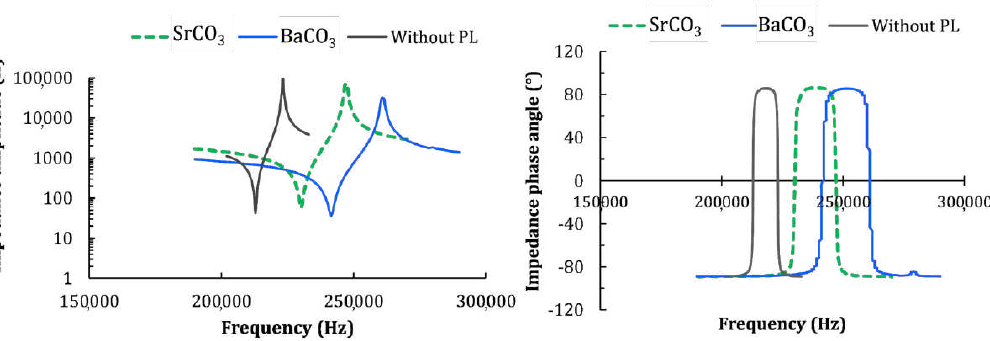
Figure 9. Comparison of impedance amplitude and impedance phase angle as a function of frequency for ceramics sintered by SPS with and without carbonates protective layers. Without PL refers to ceramics fabricated by SPS without a protective layer and post-annealed at 800 ◦ C for 6 h. These values are approaching those of a commercial PZ26 bulk ceramic ( k e ff ≈ 50%) and remain appropriate for applications such as Structural Health Monitoring